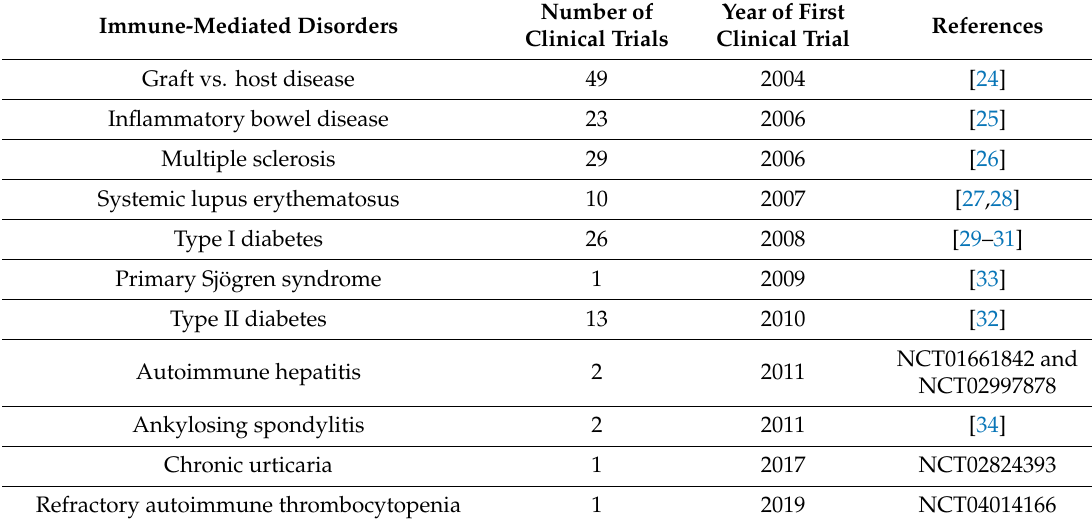
Table 1. Immune-mediated disorder clinical trials using mesenchymal stem / stromal cell (MSC)